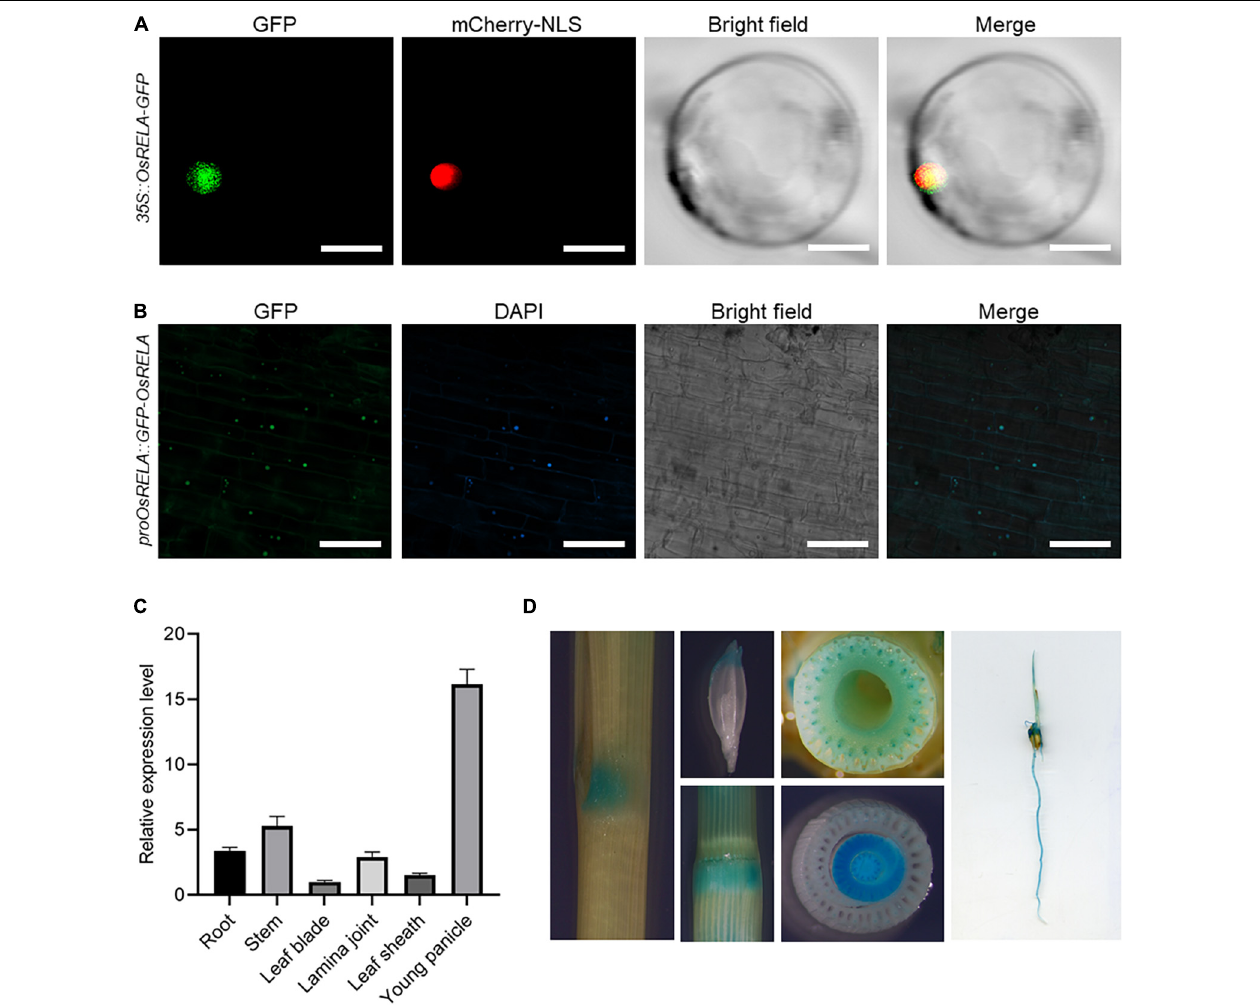
FIGURE 3 | Subcellular localization and tissue expression patterns of OsRELA . (A) Subcellular localization of the OsRELA-GFP fusion protein in rice protoplasts. mCherry-NLS was used as the nuclear marker. Bar = 20 µ m. (B) Fluorescent signals in transgenic rice plants expressing GFP-OsRELA. The nuclei were counterstained with 4 (cid:48) ,6-diamidino-2-phenylindole (DAPI). Bar = 80 µ m. (C) RT–qPCR analysis of the expression patterns of OsRELA in various tissues, including root, stem, leaf blade, lamina joint, leaf sheath and young panicle. The rice UBQ gene was amplified as the internal control. (D) Examination of GUS activity in transgenic plants expressing proOsRELA:GUS . GUS activity is found in the lamina joint, young florets, stem, vascular bundles, leaf sheath and root.